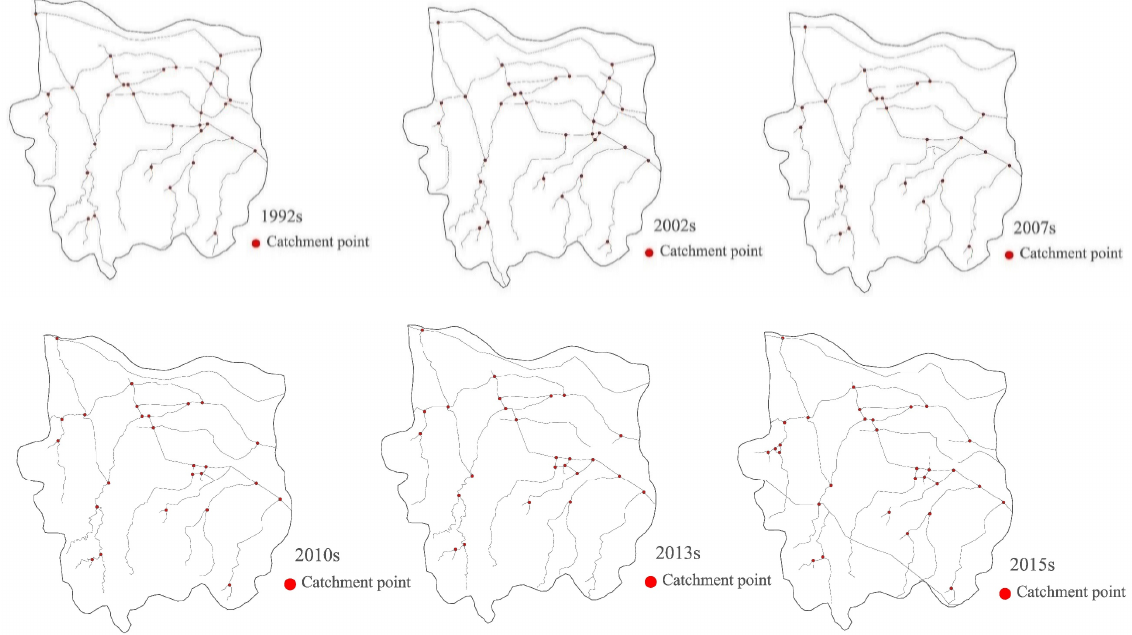
Figure 4. Schematic diagram of the evolution of the water system in Zhengzhou in various periods.